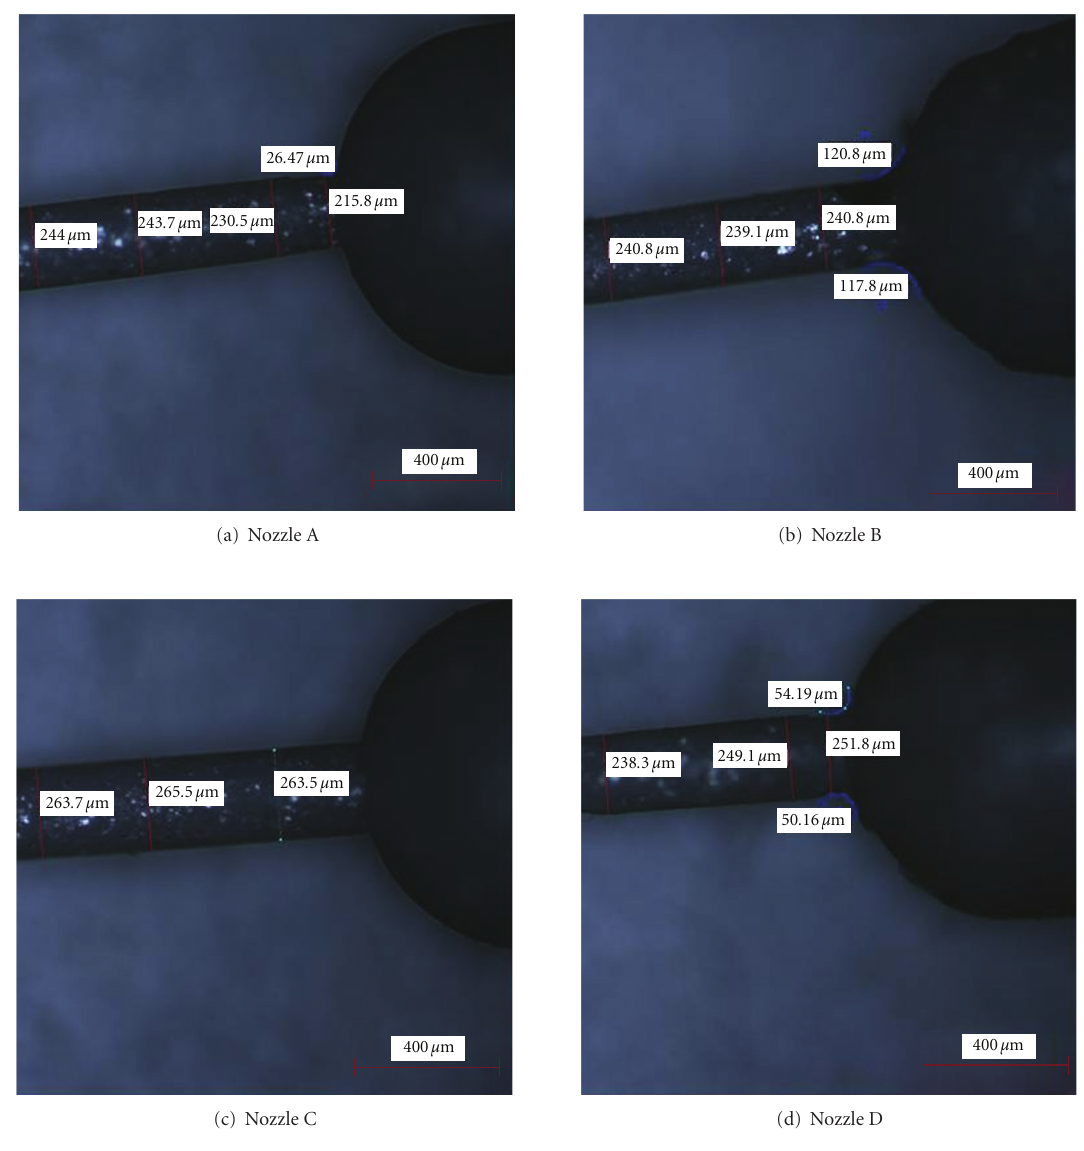
Figure 23: The silicon mold measurements of nozzle